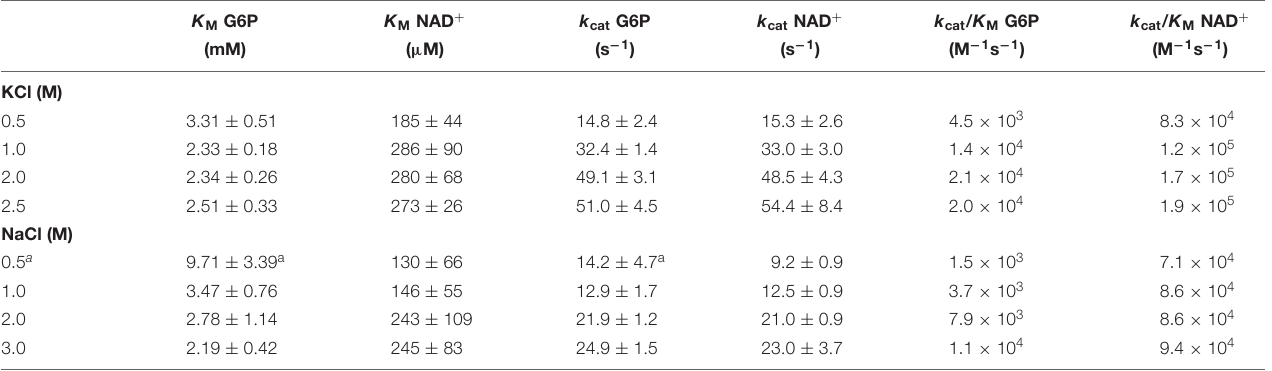
TABLE 1 | Kinetic constants of glucose-6-phosphate dehydrogenase from Haloferax volcanii (HvG6PDH) at 25 ◦ C. K M